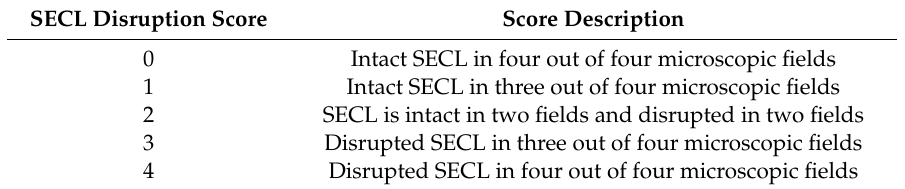
Table 1. Scoring scale of squamous epithelial cell lining (SECL) disruption in salmon skin after skin mucus